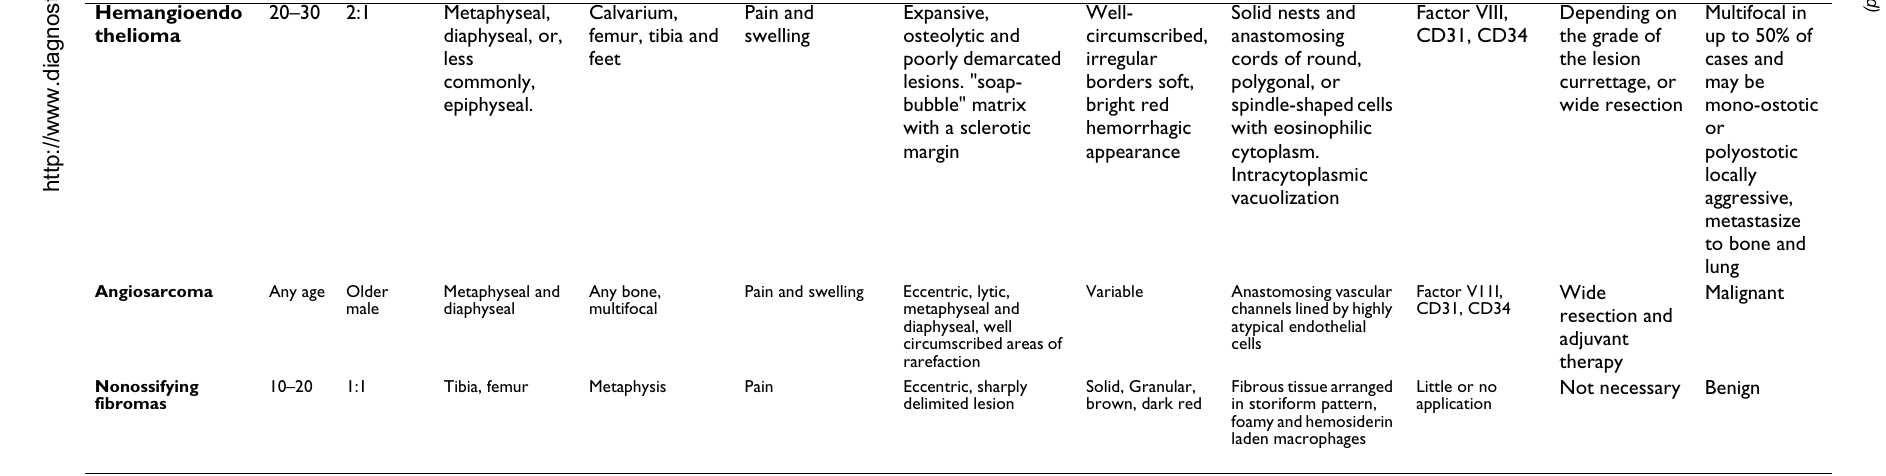
Table 6: Differential diagnosis of Adamantinoma